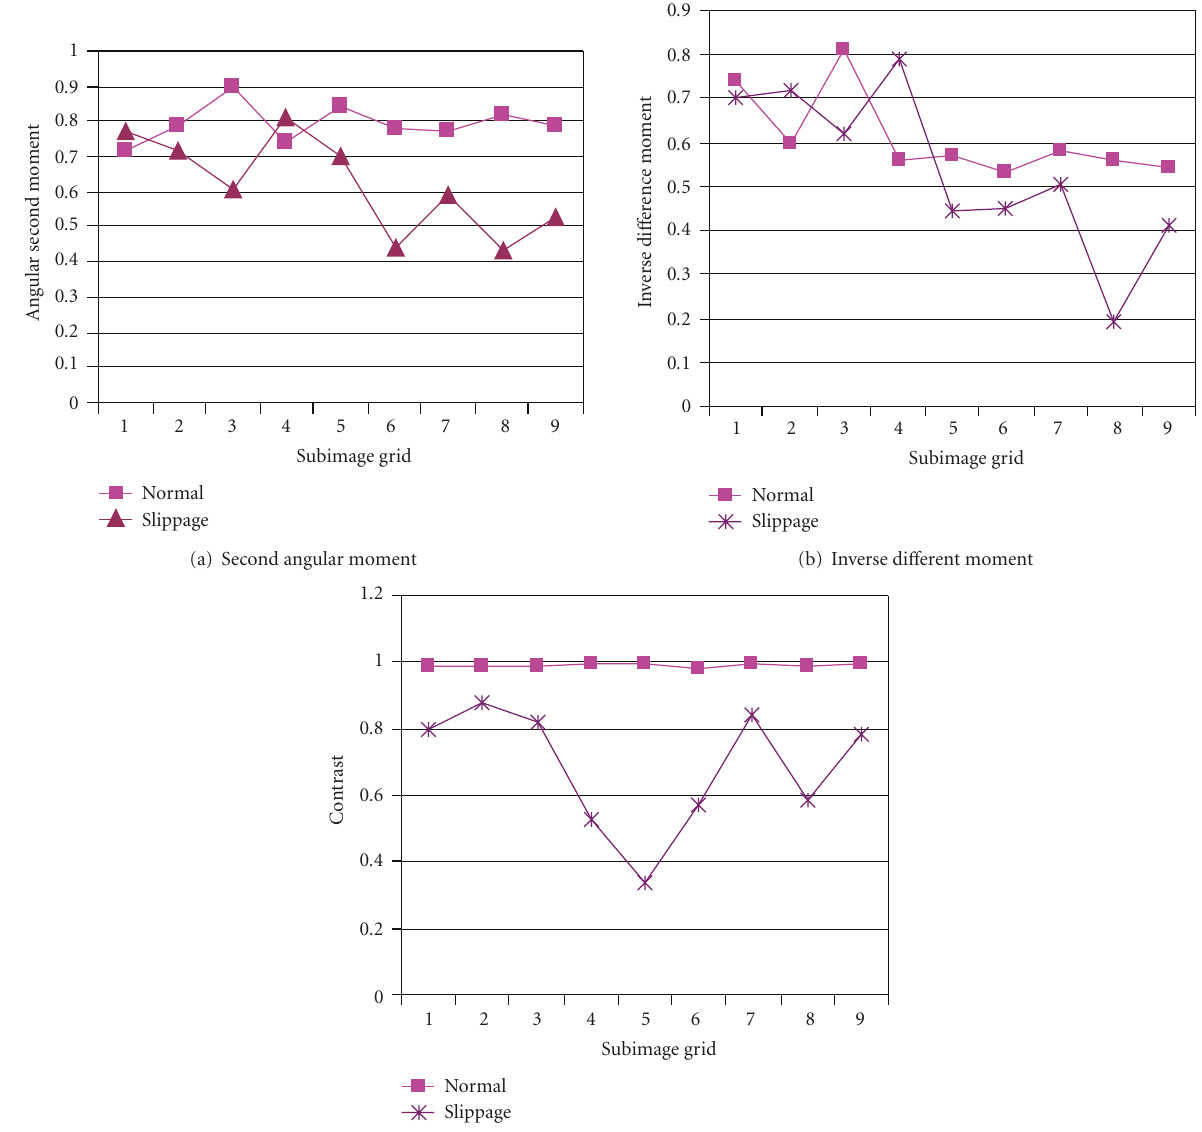
Figure 8: Normalized feature values for Figures 6(b) and